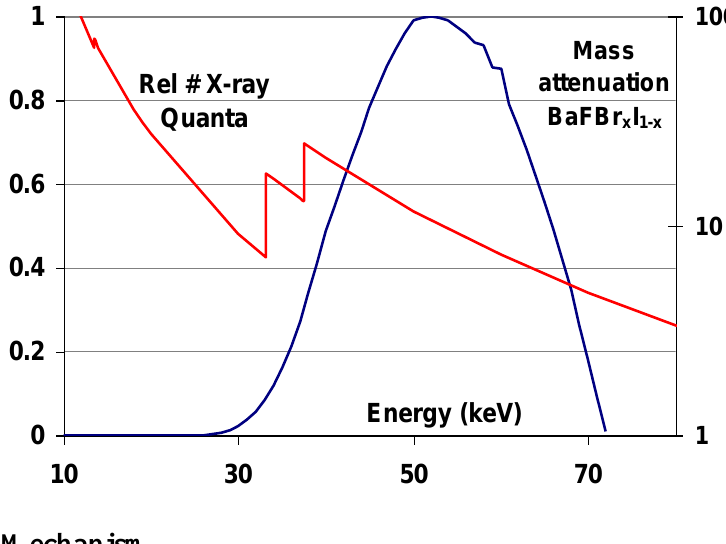
Figure 8. Overlay of the mass attenuation coefficient of BaFBr radiography X-ray